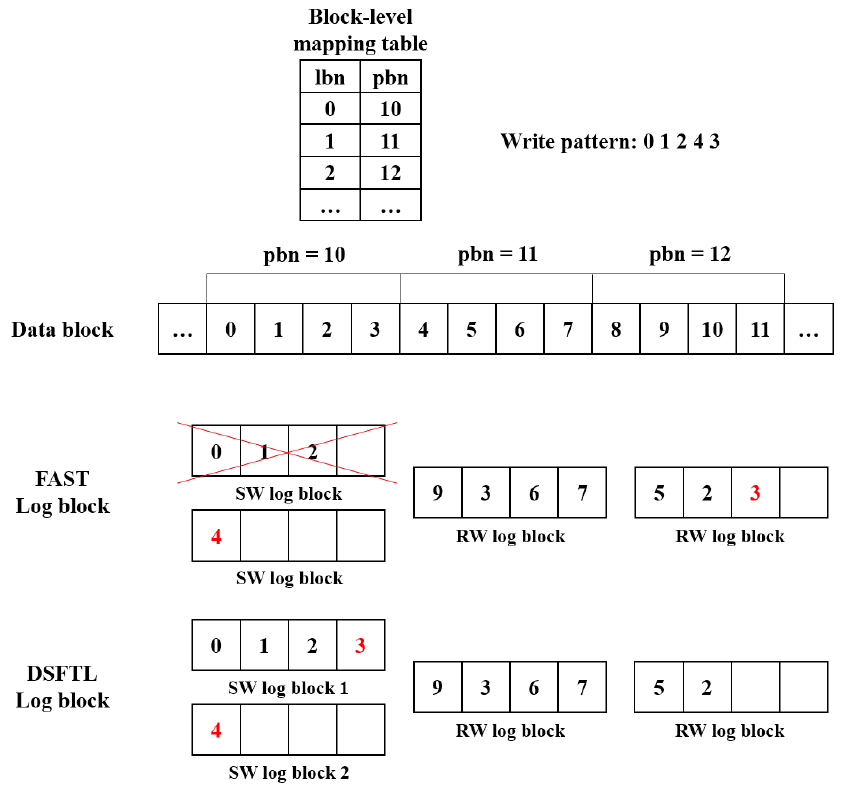
Figure 5. When data are written in an SW log block.